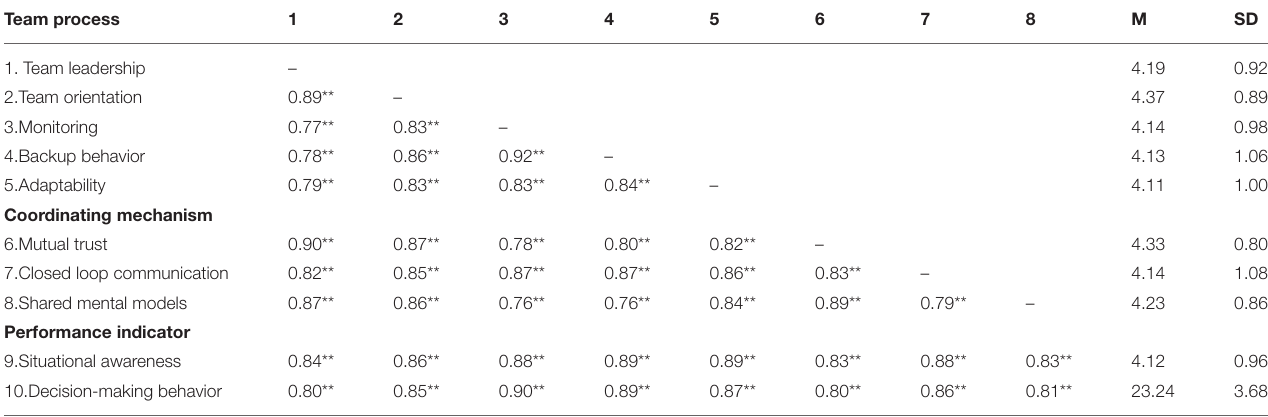
TABLE 1 | Means (M), Standard Deviations (SD), and Intercorrelations between the coordinating mechanisms, the big-five teamwork processes and performance indicators.